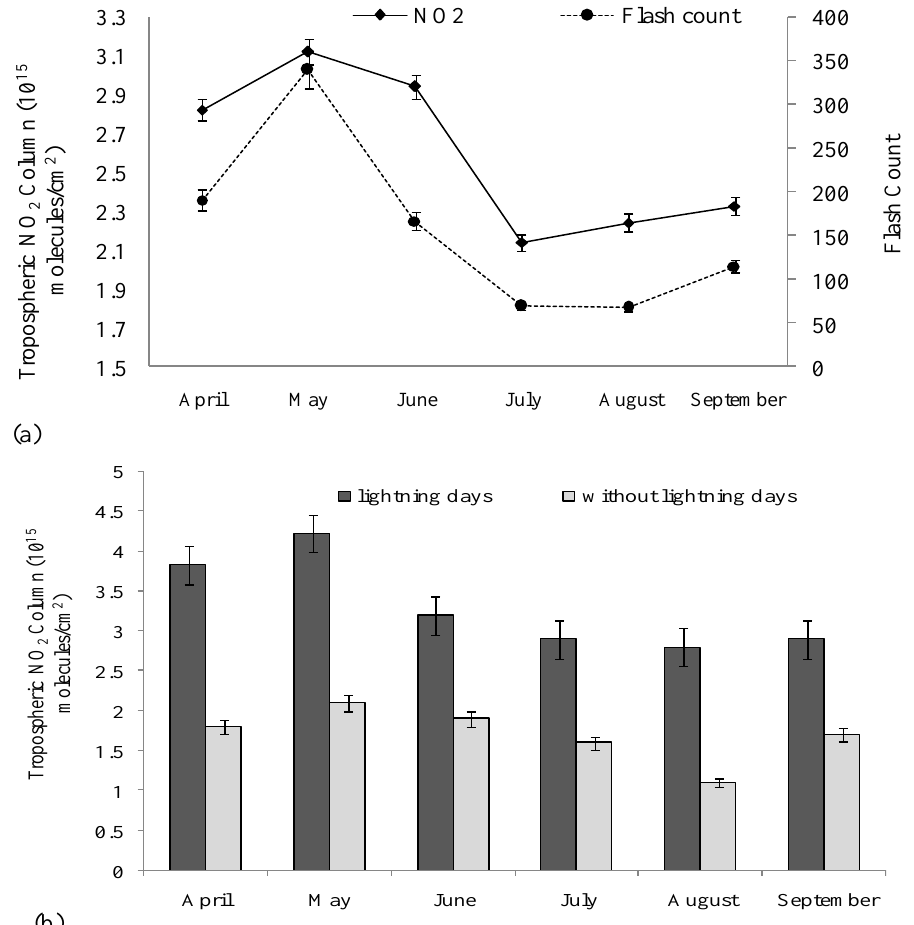
Figure 7. Relation between tropospheric NO2 and lighting activity ( a ) Variations of monthly average tropospheric NO 2 column amount and lightning flash count from 2004 to 2011 and ( b ) average tropospheric NO 2 column amount of lightning and non-lightning days from 2005 to 2011. Error bars represent first standard deviation of the parameter.